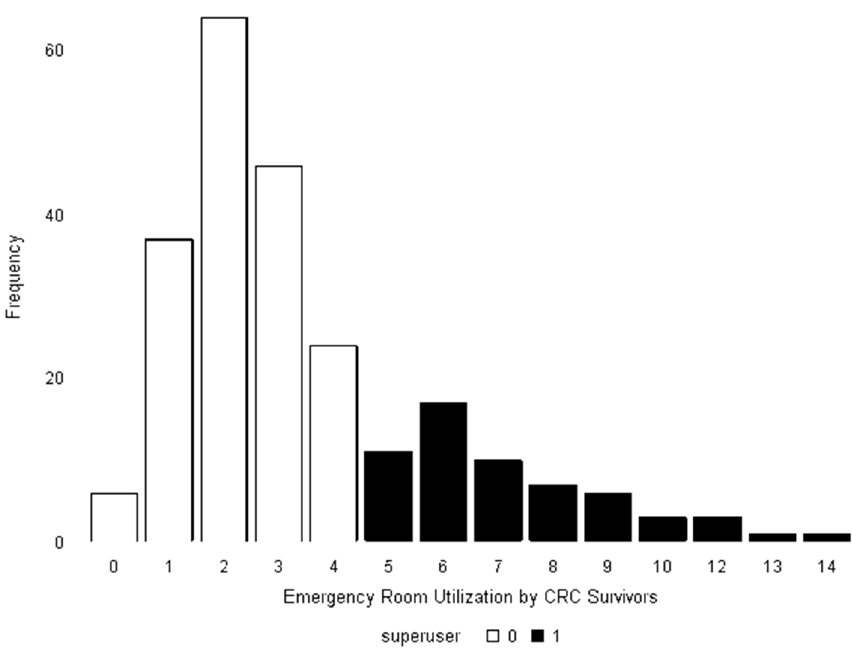
Figure 1. Distribution of “super-utilizers” of the emergency room among adolescent and young adult colorectal cancer survivors.